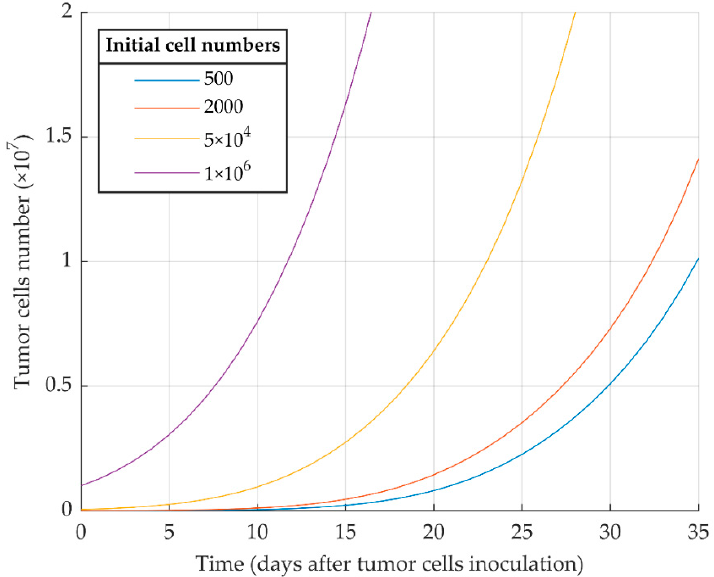
Figure 2. Mathematical simulation of proliferative WT 4T1 tumor growth with different initial cell numbers. The more tumor cells are injected initially, the sooner the tumor exponential growth starts.